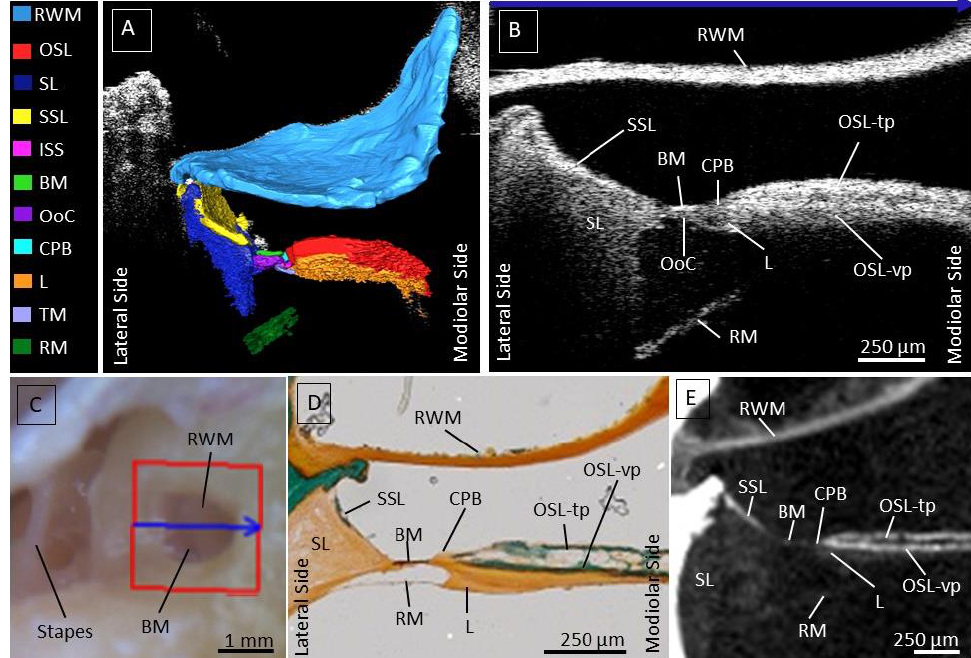
Figure 1. ( A ): Segmentation of a 3D OCT image; each structure is illustrated in a different color indicated in the legend. ( B ): OCT cross-section, with an a-scan rate of 10 kHz. Highly scattering structures result in whiter color, nicely indicating the border between the SSL and SL and CPB and OSL. ( C ): Corresponding microscopic view of the RWM, with the blue arrow indicating the location of the cross-section in ( B ). The location of the BM is visible through the transparent RWM as a dark line beneath the RWM. The stapes is located superior to the RWM. ( D ): Histology with Masson-Goldner staining as a reference to the structures on the OCT images. ( E ): Microcomputed topographical image, providing an extra comparison for the visualized structures on the OCT image in ( B ). Abbreviations: Round window membrane (RWM), Osseous spiral lamina—tympanic plate (OSL-tp), vestibular plate (OSL-vp), cochlear partition bridge (CPB), Basilar Membrane (BM), Organ of Corti (OoC), Secondary spiral lamina (SSL), Spiral ligament (SL), Spiral Limbus (L) and Reissner’s Membrane (RM). Underneath the RWM, the osseous spiral lamina (OSL) separates the scala tympani (ST) from the scala vestibuli (SV). This structure is recognizable on the one hand due to the gap between the vestibular (OSL-vp) and tympanic plate (OSL-tp), indicating the location